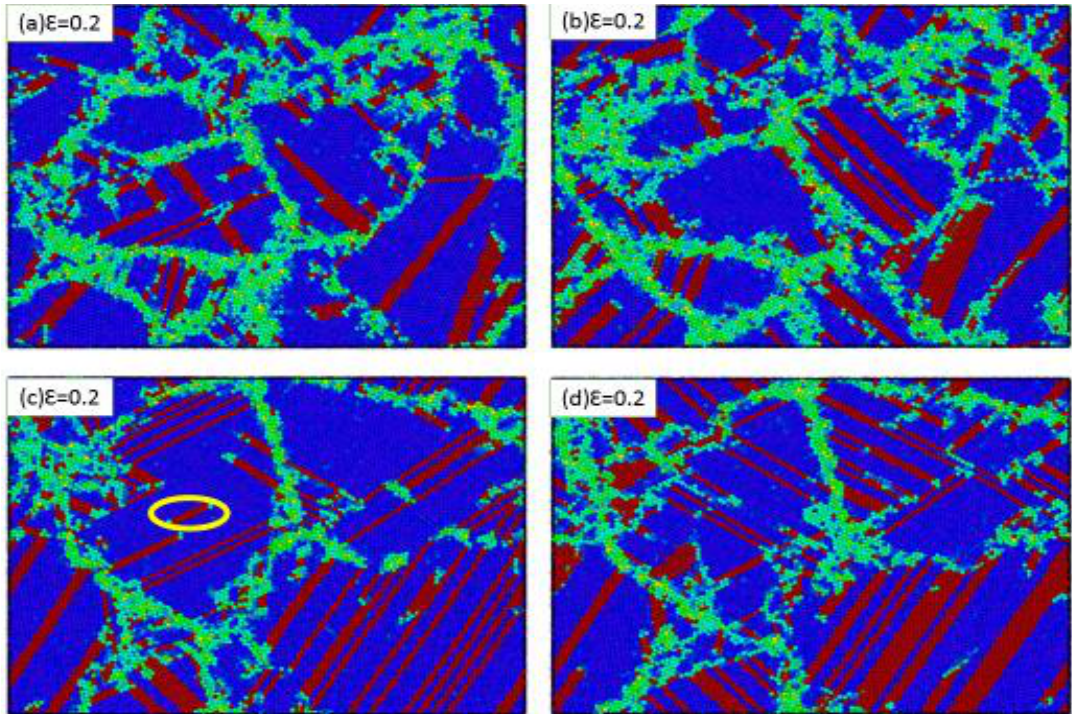
Figure 7. Snapshots of the simulated stainless-steel with the strain increases to 0.20. Each sample shows the strain accumulation for the sample at 6 × 10 9 s − 1 and 1 × 10 10 s − 1 . This is presented in ( a ) and ( c ) with grain size 2.5 nm; ( b ) and ( d ) with grain size 9.9 nm, respectively.